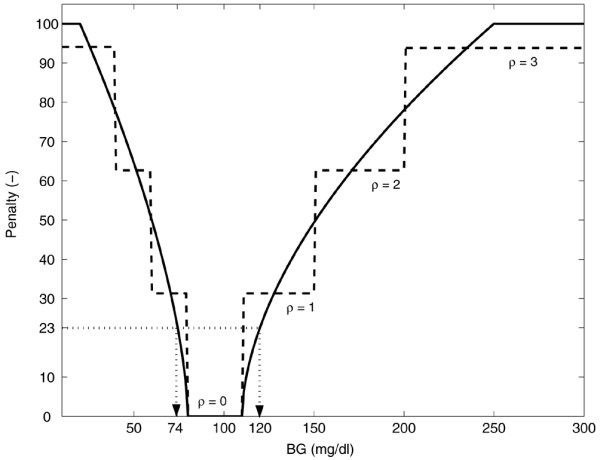
Penalty index as a function of blood glucose (BG). Each BG observation corresponds to a penalty. The dashed line represents the staircase penalty index function (here, the penalty is denoted as ρ). For reasons explained in the text, this staircase function was transformed into a more smoothed penalty index function, which is illustrated by the solid line. The penalties are symbolized by β, γ, and δ for the low, normal, and high BG measurements, respectively. The 'clinically acceptable' cut-off glycemic penalty index (GPI) equals 23 and corresponds to a 'clinically acceptable' BG range of 74–120 mg/dl. The target normoglycemic range, however, remains 80 to 110 mg/dl with a corresponding penalty value equal to 0.